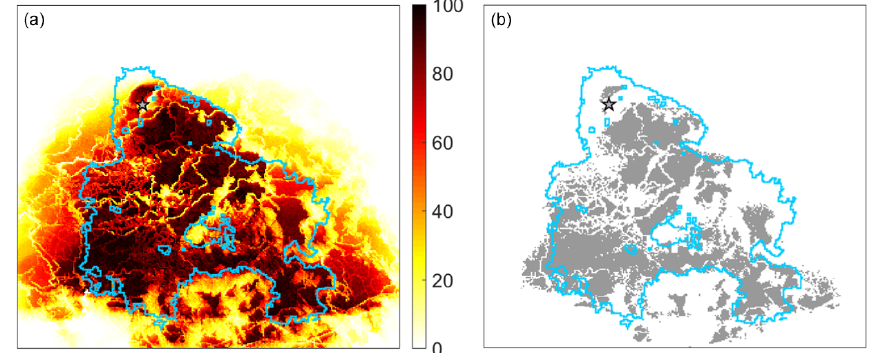
Figure 11. (a) Probabilities of burning (%) as derived from an ensemble of 100 unconstrained simulations of the modified model. The color bar indicates the probability of burning. The star represents the fire ignition point, the black line the perimeter of the burned area and white the unburned cells. (b) Burned sites identified above a threshold probability of 80%. The blue arrows indicate locations where fire fighting occurred, namely along the lateral sides of the burned scar and populated